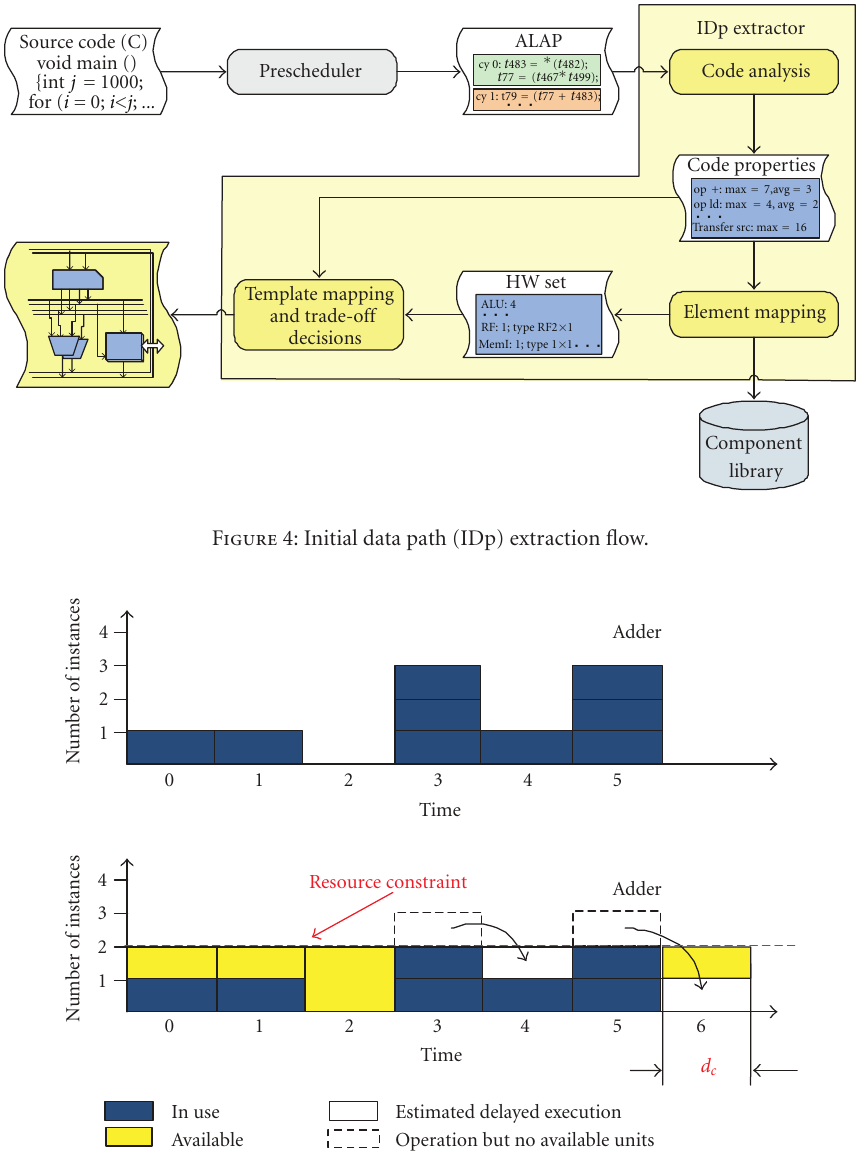
Figure 5: d c Computation for given resource